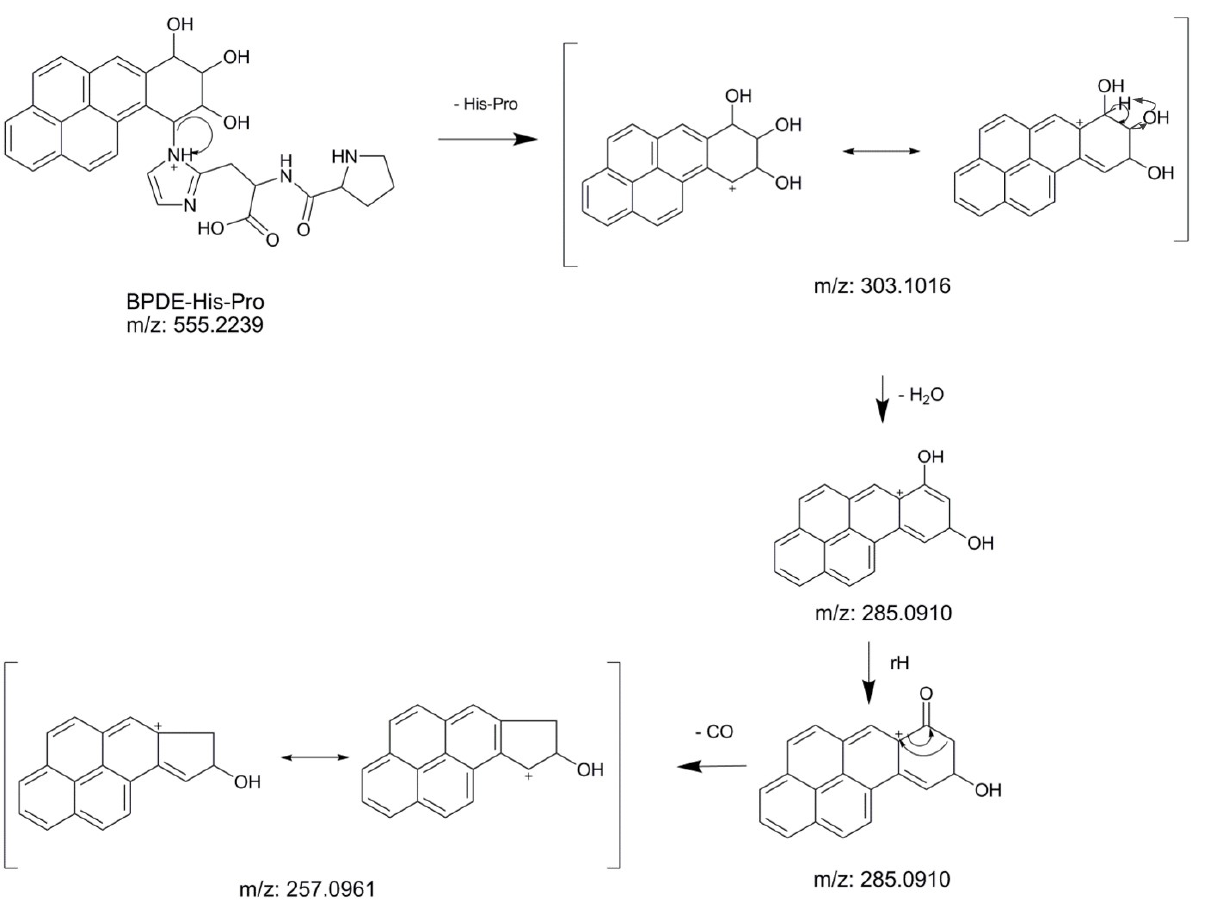
Figure 2. Fragmentation mechanism proposal for BPDE-His-Pro with theoretical m/z values given.